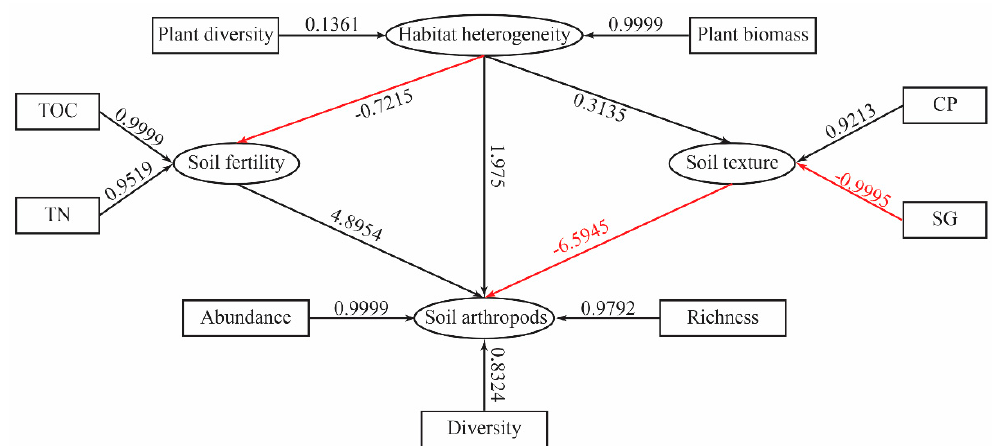
Figure 5. Structural equation model relating vegetation heterogeneity, soil fertility, soil texture and soil macro-arthropod communities ( χ 2 = 9.145, p = 0.865, GFI = 0.899, CFI = 0.907, RMSEA = 0.000). The rectangles represent the observed variables (plant diversity, biomass, soil organic matter, total N, soil clay particle, sand grains, abundance, richness and diversity); and the ovals represent latent variables (vegetation heterogeneity, soil fertility, soil texture and soil macro-arthropod communities). The red arrows indicate negative correlation between each variable; and the black arrows indicate positive correlation between each variable. The numbers indicate correlation coefficients.